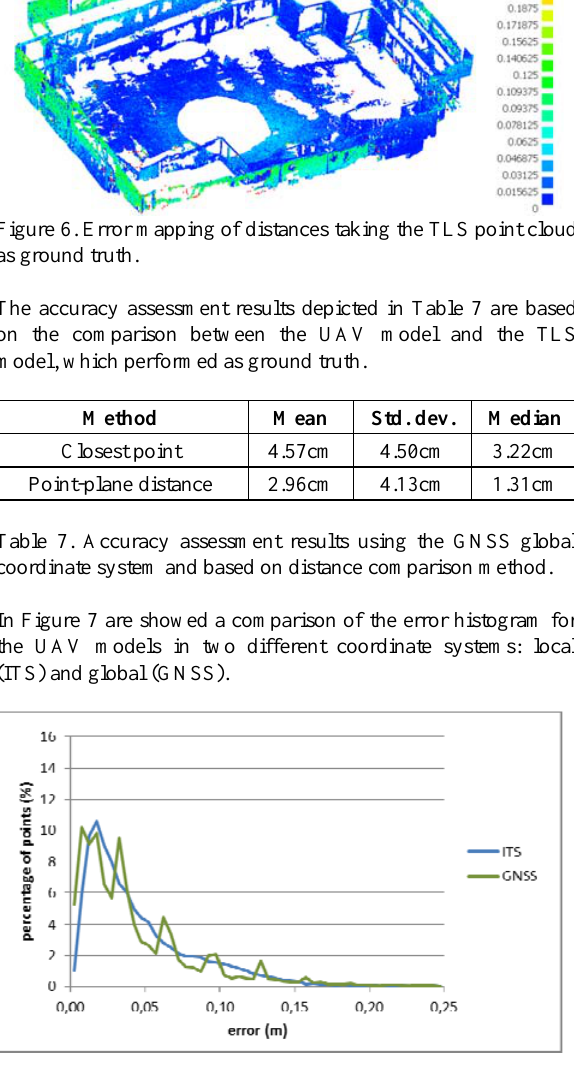
Figure 7. Relative accuracy histogram of the closest point distance error for both coordinate frames (ITS ans